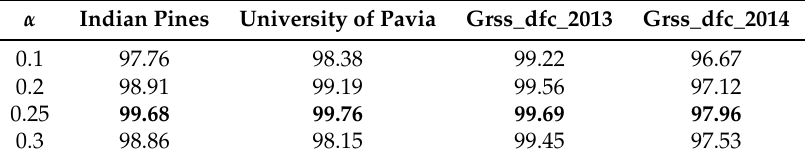
Table 9. Overall accuracy (OA) of the proposed method with different α .